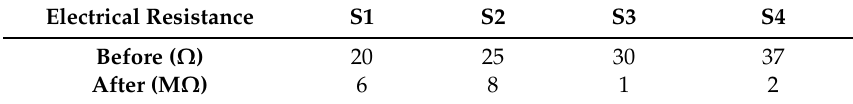
Table 2. Measured resistance of four sensing points before and after annealing process.